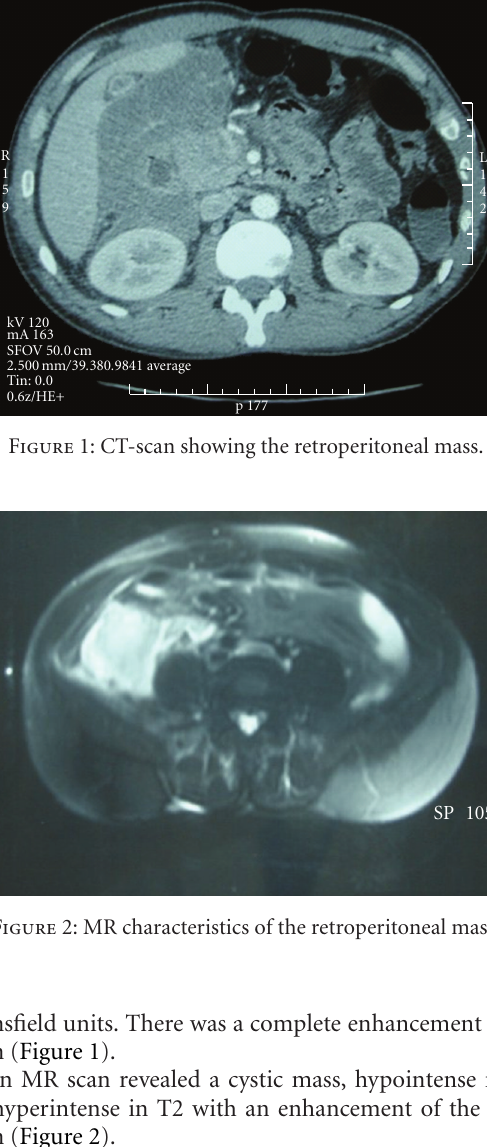
Hounsfield units. There was a complete enhancement of the lesion (Figure 1).